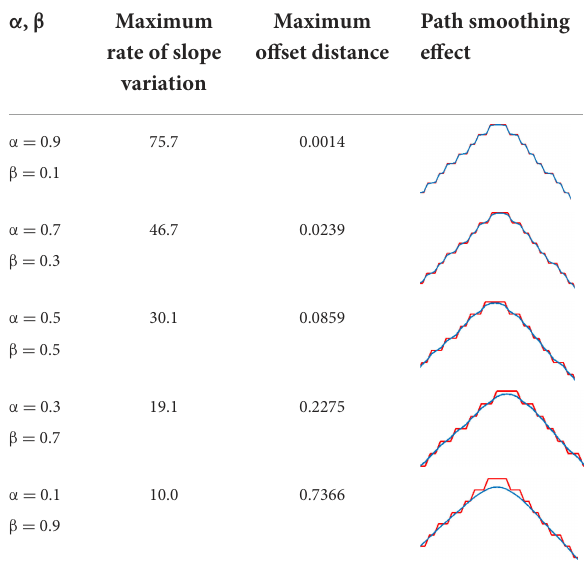
TABLE 2 Path smoothing simulation results with different